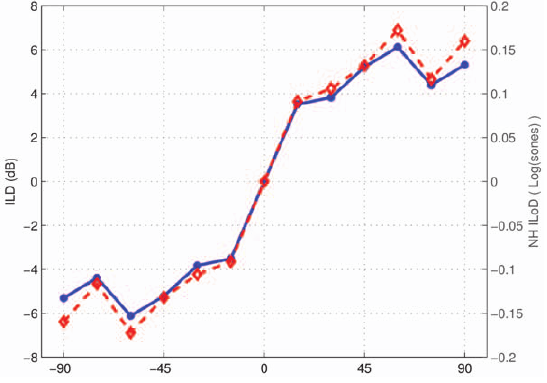
Figure 7. Interaural level and loudness differences for the speech-weighted click train used in the localisation experi- ments and simulations. ILDs in dB are shown in blue with round markers and the corresponding interaural loudness differences for a normal-hearing listener are shown in red with diamond markers.